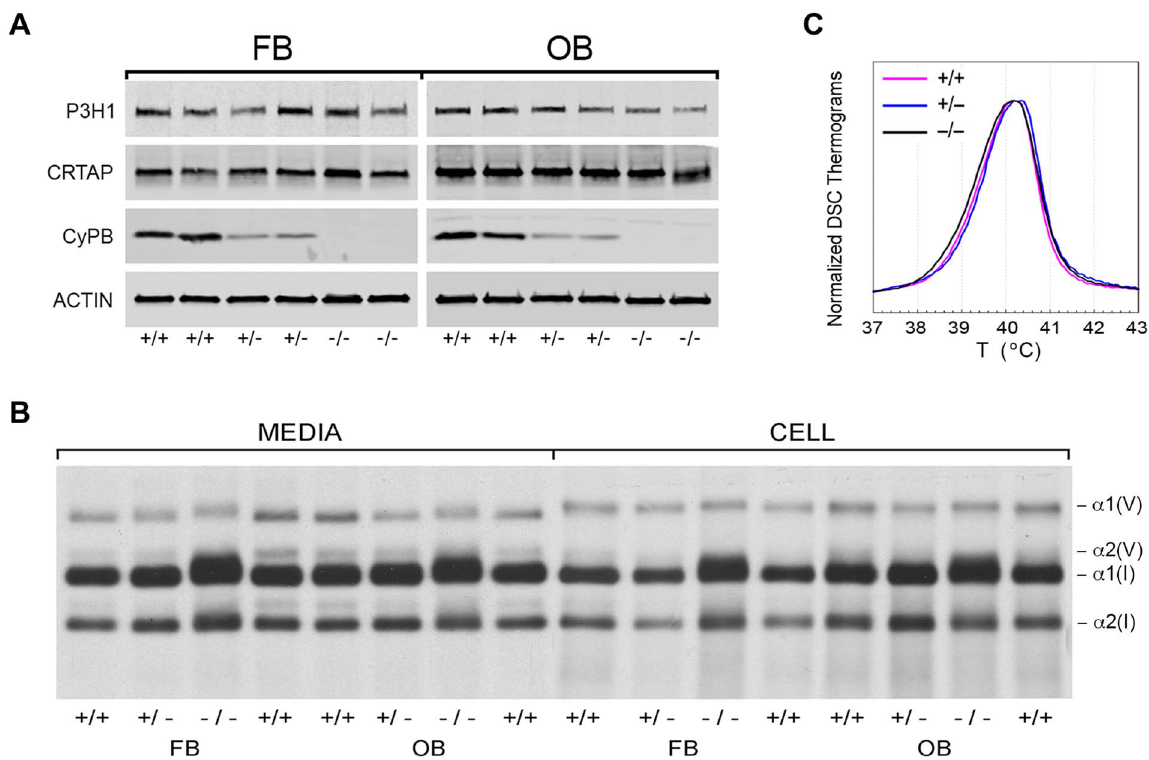
Figure 4. Synthesis of type I collagen. (A) Western blots of cell lysates with antibodies to collagen 3-hydroxylation complex components. Lysates are derived from two independent cultures for each genotype. (B) SDS-Urea PAGE analysis of steady-state labeled type I collagen from wild-type ( + / + ), heterozygous ( + / 2 ) and homozygous ( 2 / 2 ) fibroblasts (FB) and osteoblasts (OB). (C) Differential scanning calorimetry (DSC) analysis reveals no differences in thermal stability (T m ) of type I collagen secreted by fibroblast